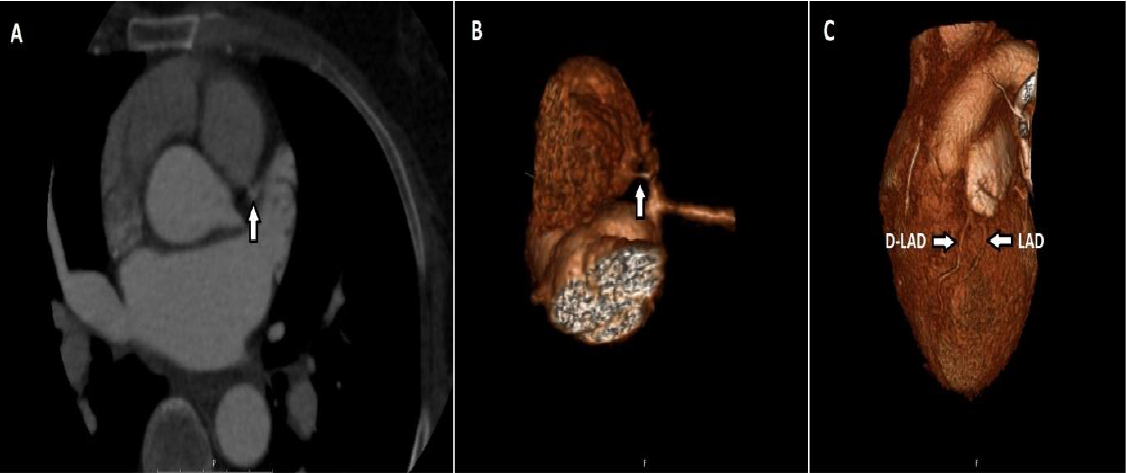
Figure 5. Axial CT maximum-intensity projection (MIP) ( A ) and volume-rendered (VR) ( B ) image shows a thin fistula line between the LAD and the main pulmonary artery. A duplicated LAD (D-LAD) with an LAD is seen in the same patient ( C ).